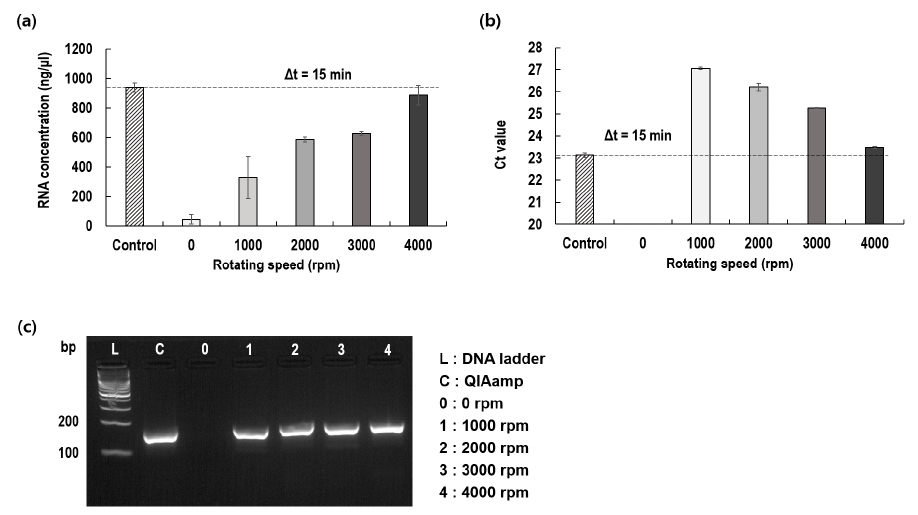
Figure 2. Effect of the rotational speed of the blade on viral RNA extraction as compared to control. ( a ) Extracted RNA concentrations; ( b ) Threshold cycles (Ct) of PCR for extracted RNA; ( c ) Gel electrophoresis for amplified RNA.